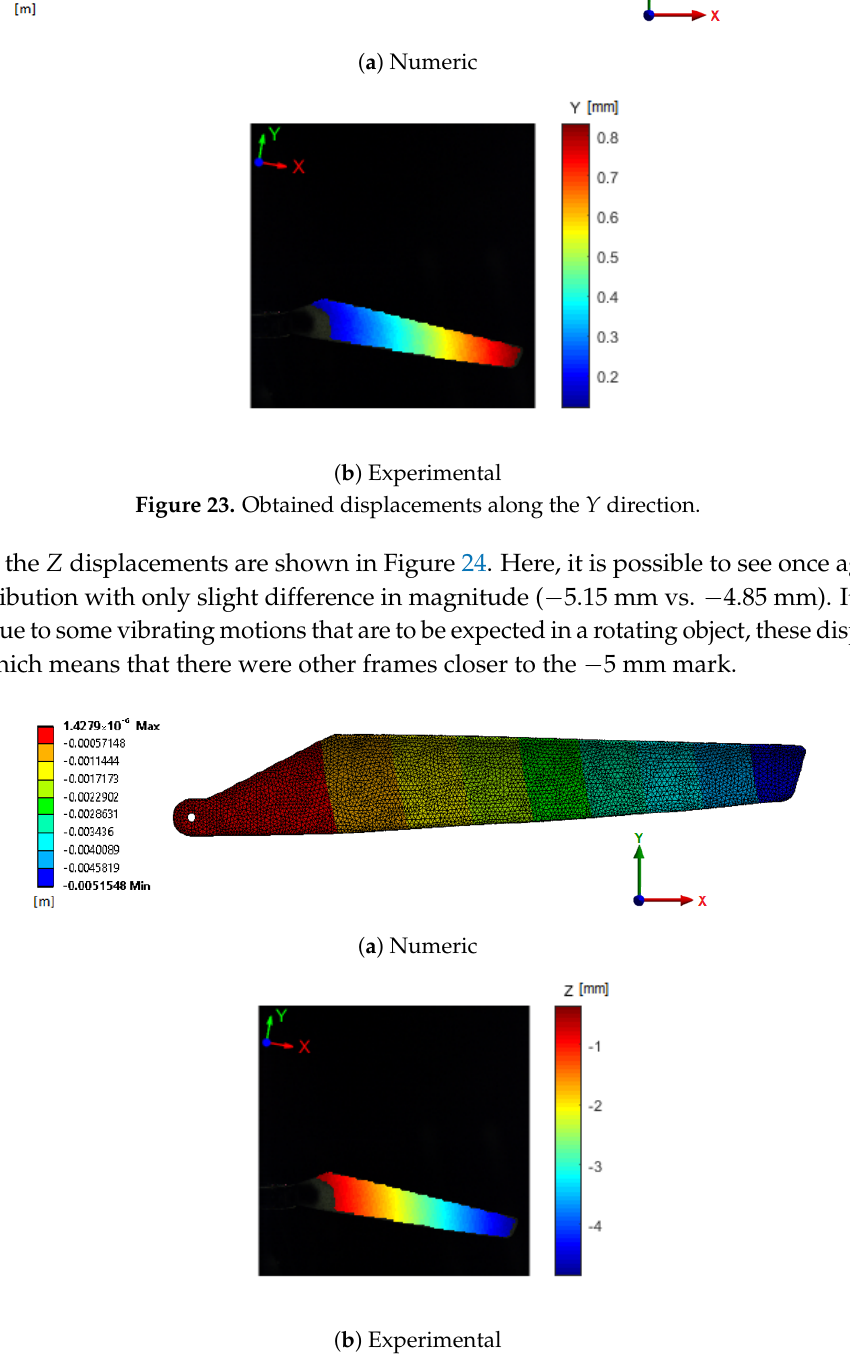
Figure 24. Obtained displacements along the Z